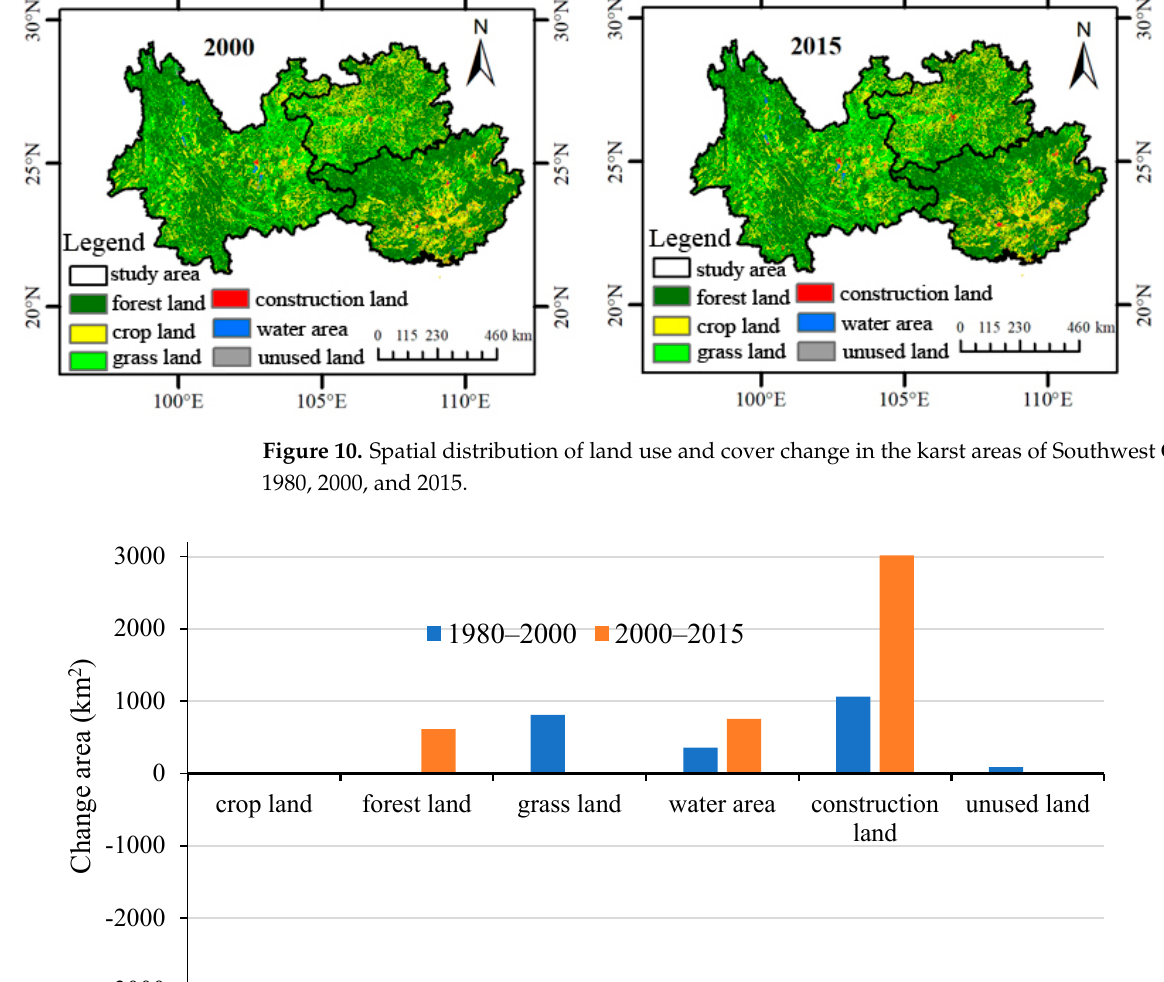
Figure 11. Land use and cover change in the karst areas of Southwest China from 1980 to 2000 and 2000 to 2015.